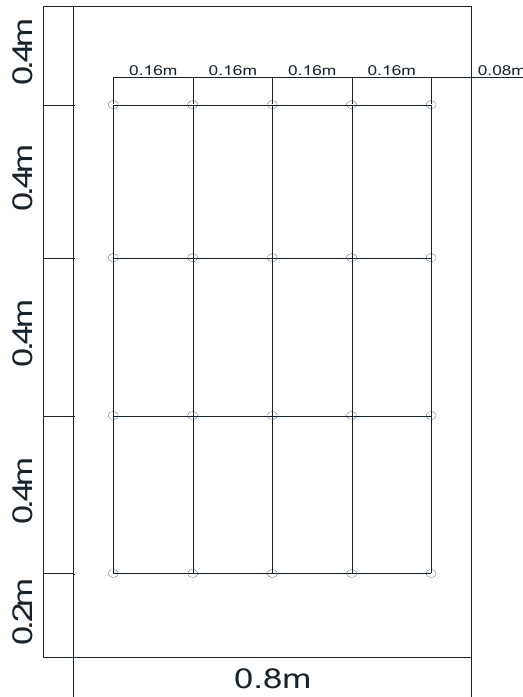
Figure 14. Layout diagram of temperature testing points.